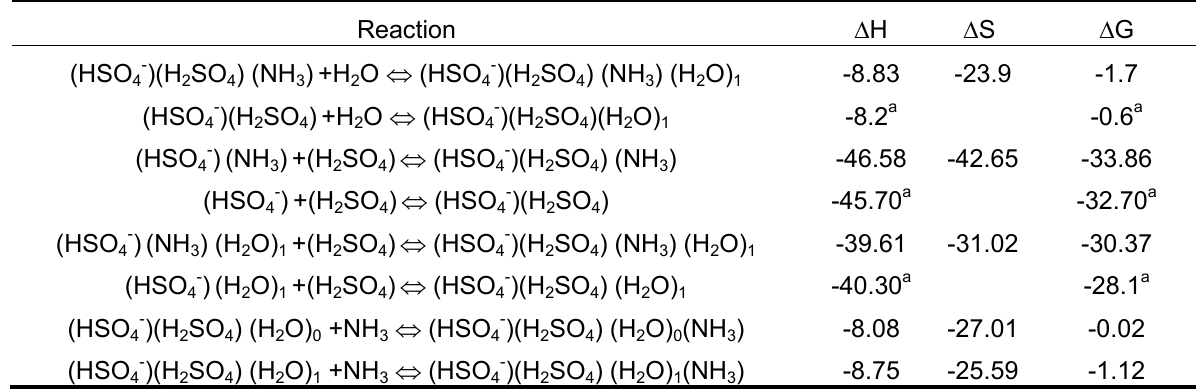
Table 4. Enthalpies (kcal mol -1 ), entropies (cal mol -1 K -1 ), and Gibbs free energy changes (kcal mol -1 ) of (HSO 4- ) (H T=298.15K and P=101.3 KPa. Superscript “ a” refers to